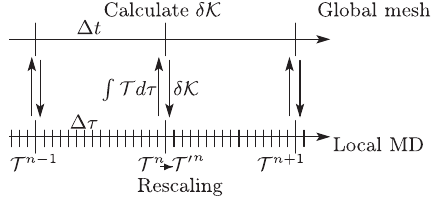
FIG. 2. A schematic for the calculation of the temperature in the SMD method. The upper side represents the progress on the global mesh system, and the lower side represents the progress at each MD cell.